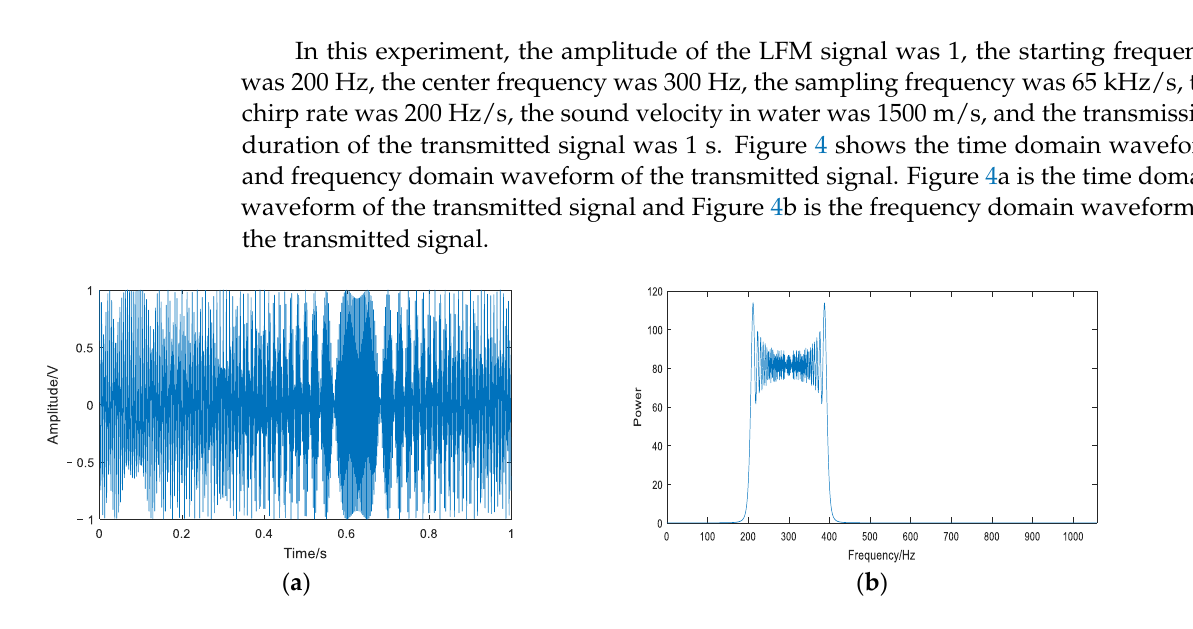
Figure 4. The time domain waveform and frequency domain waveform of the transmitted signal: ( a ) the time domain waveform of the transmitted signal; ( b ) the frequency domain waveform of the transmitted signal.